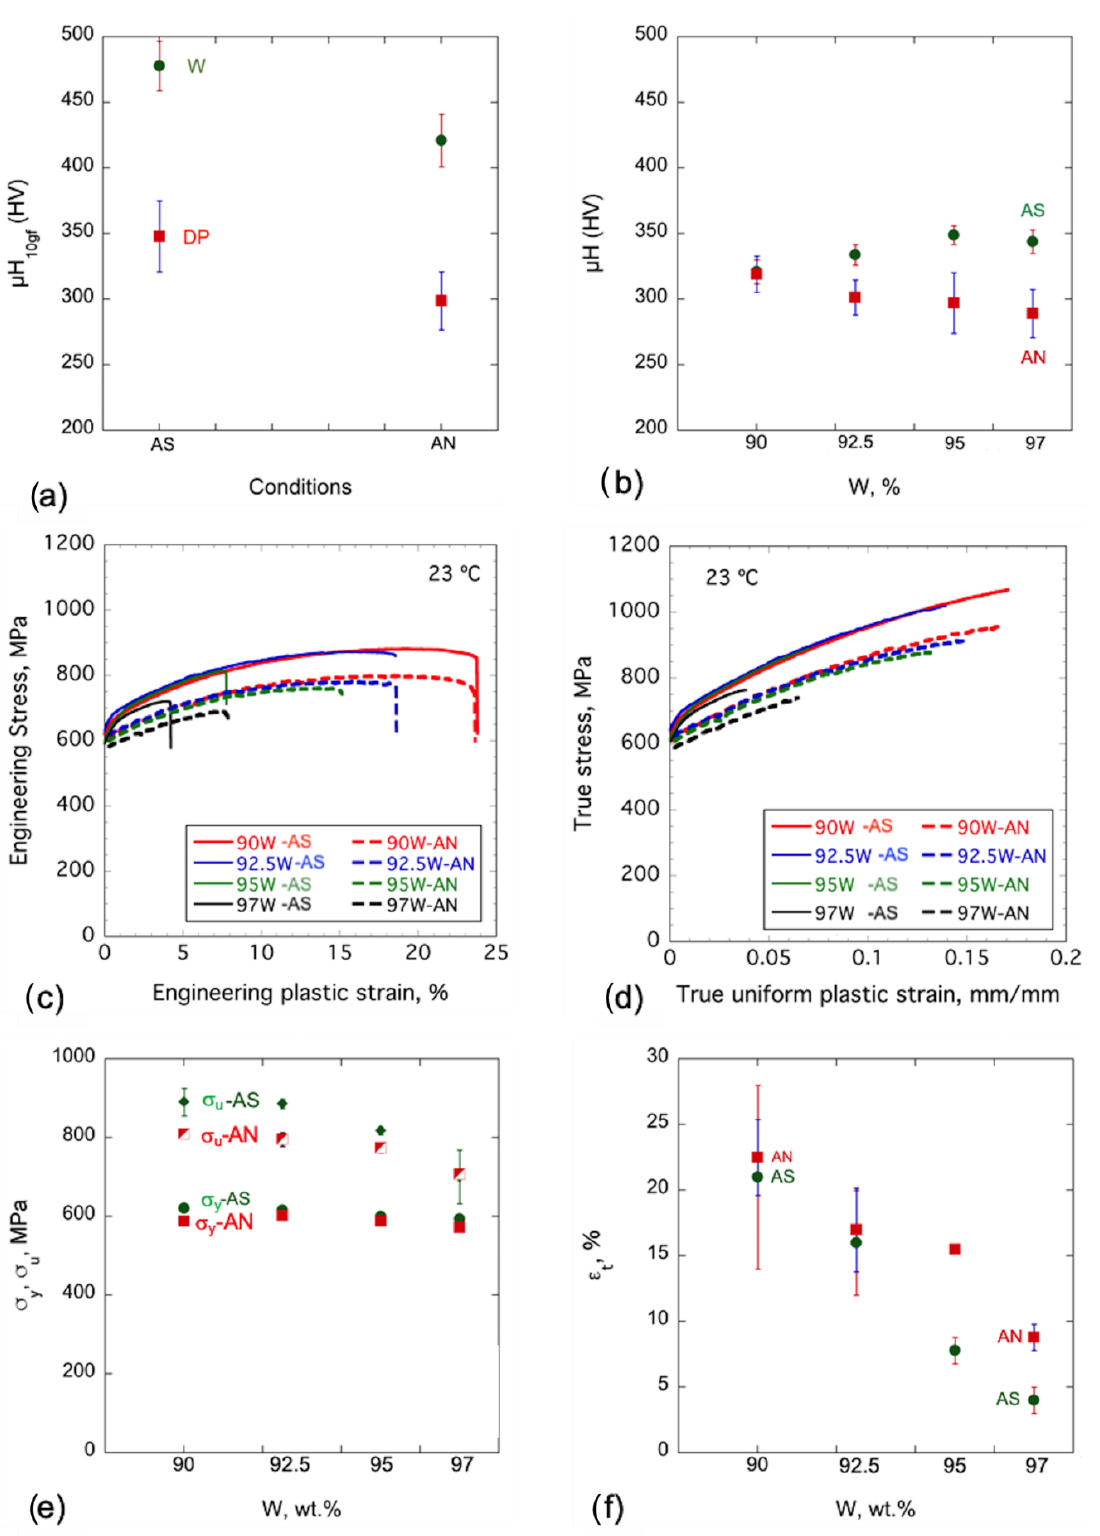
Figure 3. Vickers microhardness HV for AS and AN WHAs for ( a ) individual W particles and DP probed at 10g f load; ( b ) the WHA composites at 500g f load; ( c ) representative RT engineering σ plastic ε p curves; ( d ) true stress-true plastic strain curves; ( e ) 0.2% yield ( σ y ) and ultimate tensile ( σ u ) strengths; and ( f ) total elongations ( ε t ) for AS (green circles) and AN (red squares) WHAs,